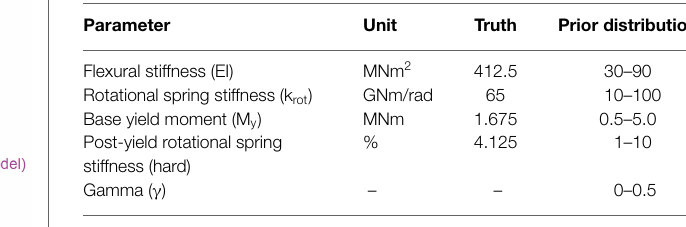
TABLE 1 | True values and prior distributions of the parameters to